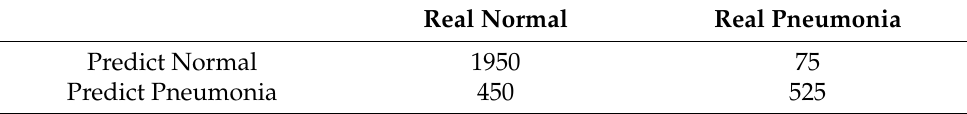
Table 15. Confusion matrix of Attention VGG16 on the synthetic-covid-cxr dataset.